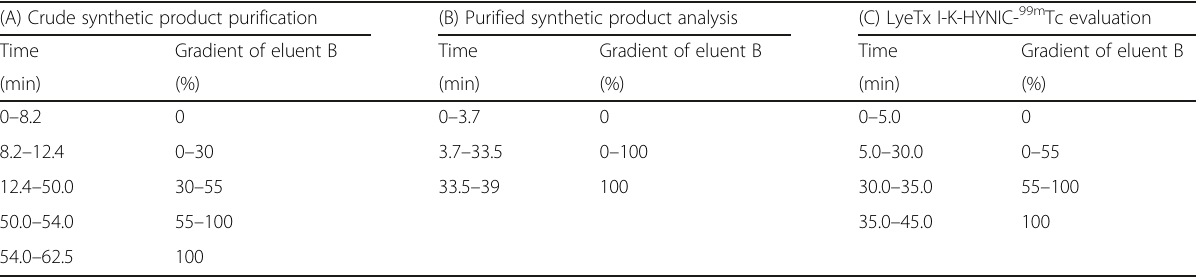
Table 1 Solvent conditions for RP-HPLC (A) Crude synthetic product purification (B) Purified synthetic product